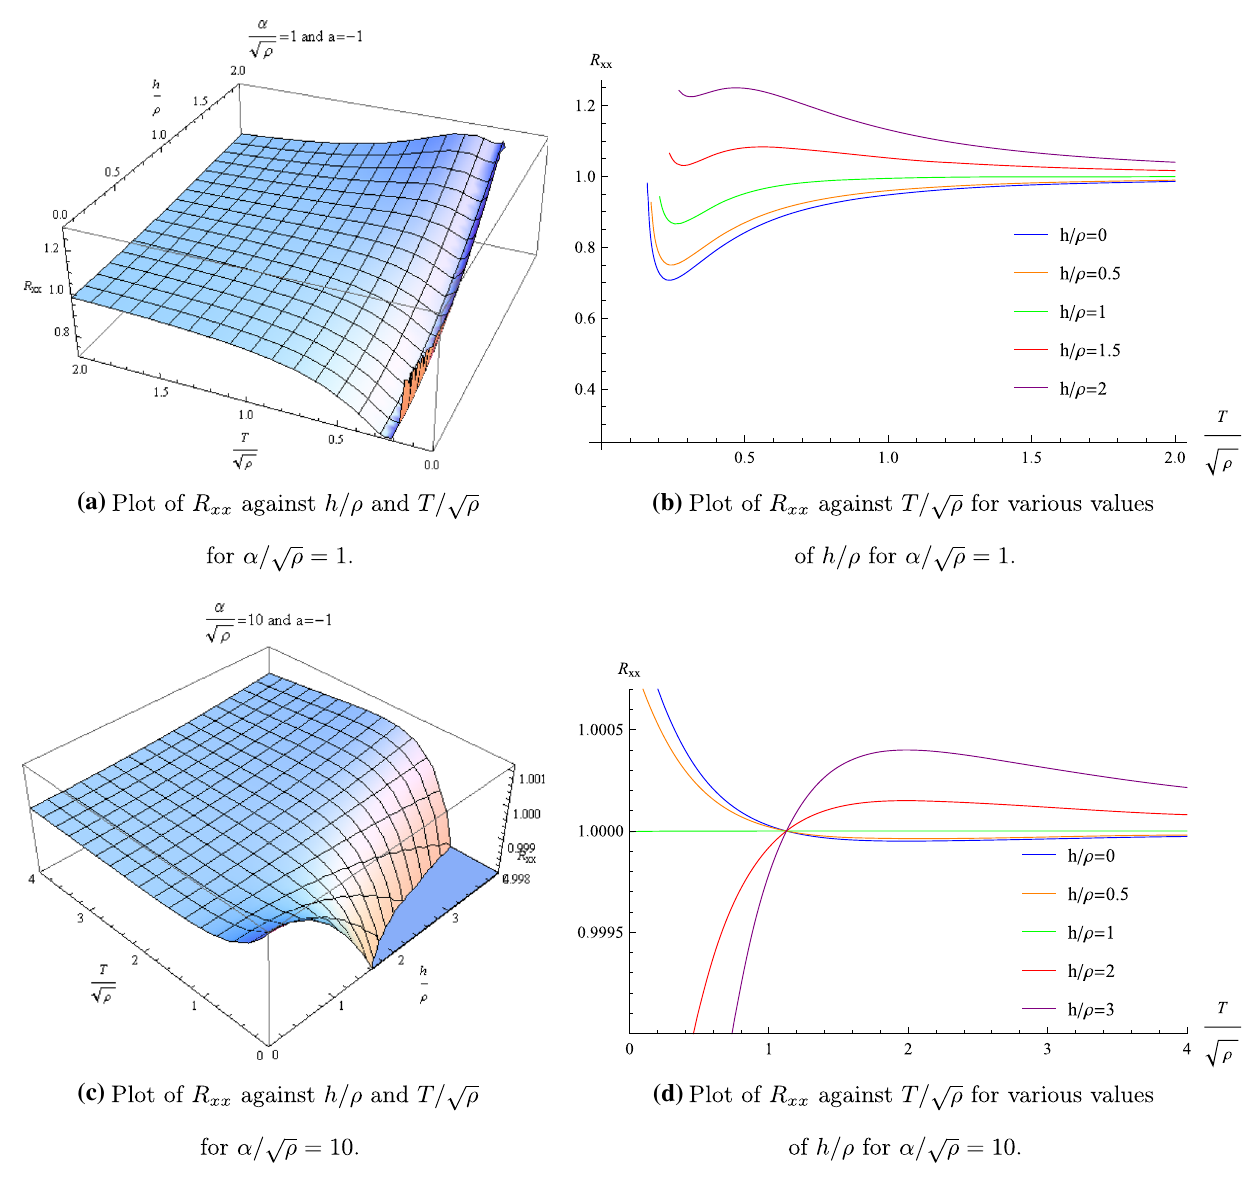
Fig. 8 Plots of the temperature dependence of R xx with α/ a = −